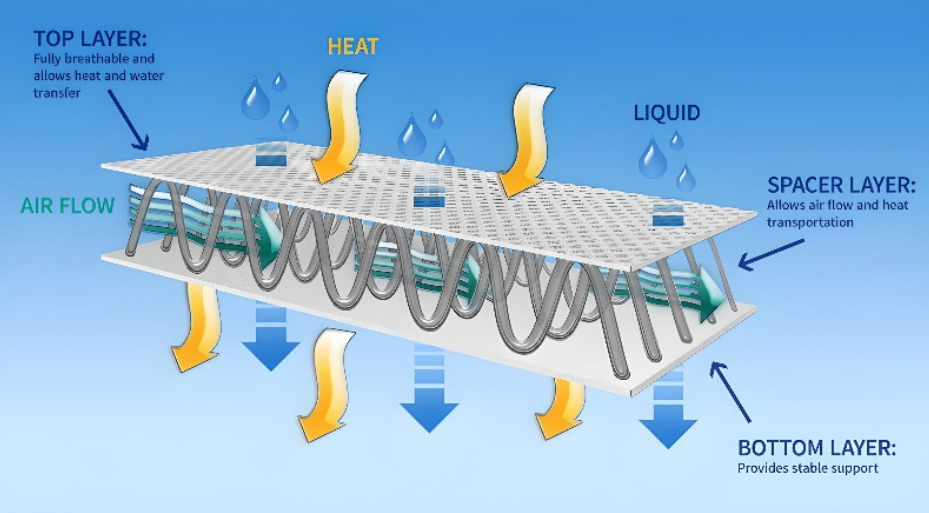
Figure 3. The structure of the spacer knitted fabric. The spacer knitted fabric (I) used for the lining was designed in the ProCad Warpknit program, in which its structure was visualized (Figure 4) The outer layer, marked in blue, with an openwork surface, is created from two component stitches made by GB1 and GB2 needle bars with incomplete threading. The inner layer made of monofilament yarn (green) is created by GB3 and GB4 needle bars. The GB5 and GB6 needle bars are responsible for creating the last outer layer with a smooth surface made of two-component stitches, marked in red.